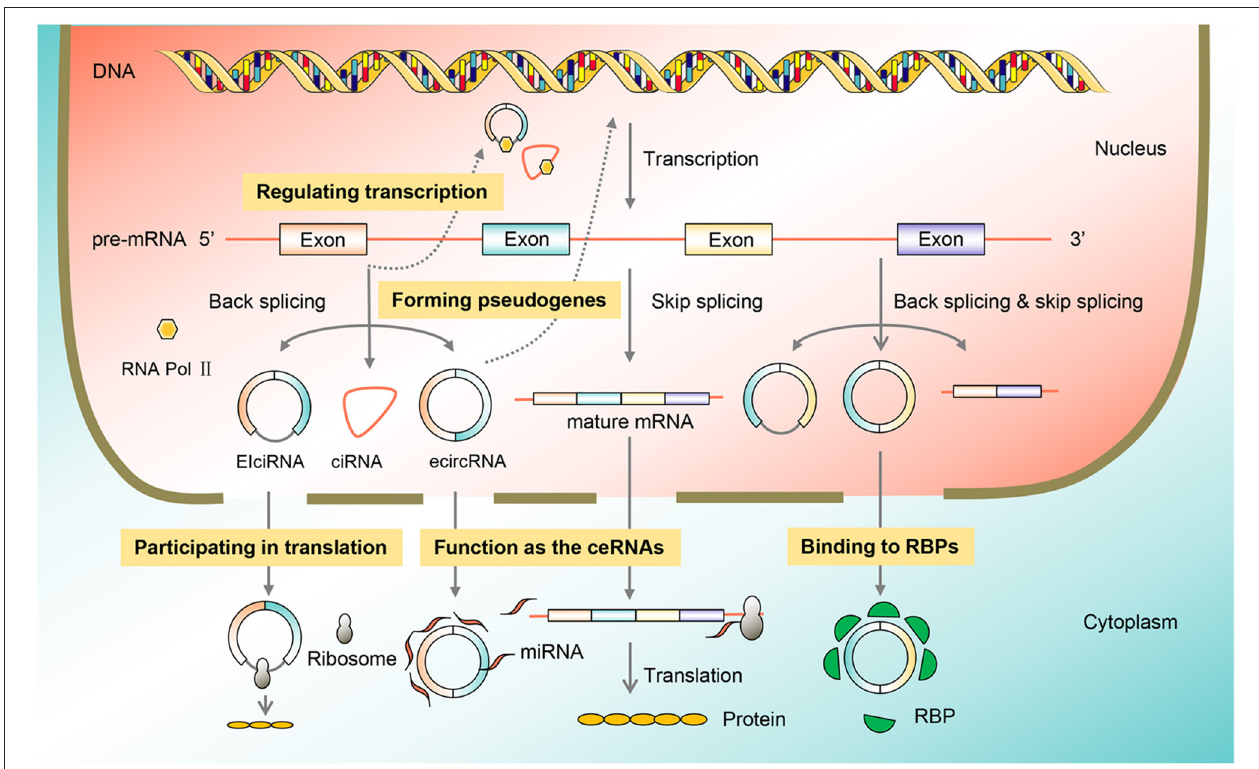
FIGURE 2 | Function classification of circRNAs. CircRNAs are omnipresent in eukaryotic cells, and their functions include acting as the ceRNAs, binding to the RBP, regulating transcription, participating in translation, and forming pseudogenes, thus participating in the process of BC. BC, breast cancer; circRNA, circular RNA; RBP, RNA-binding